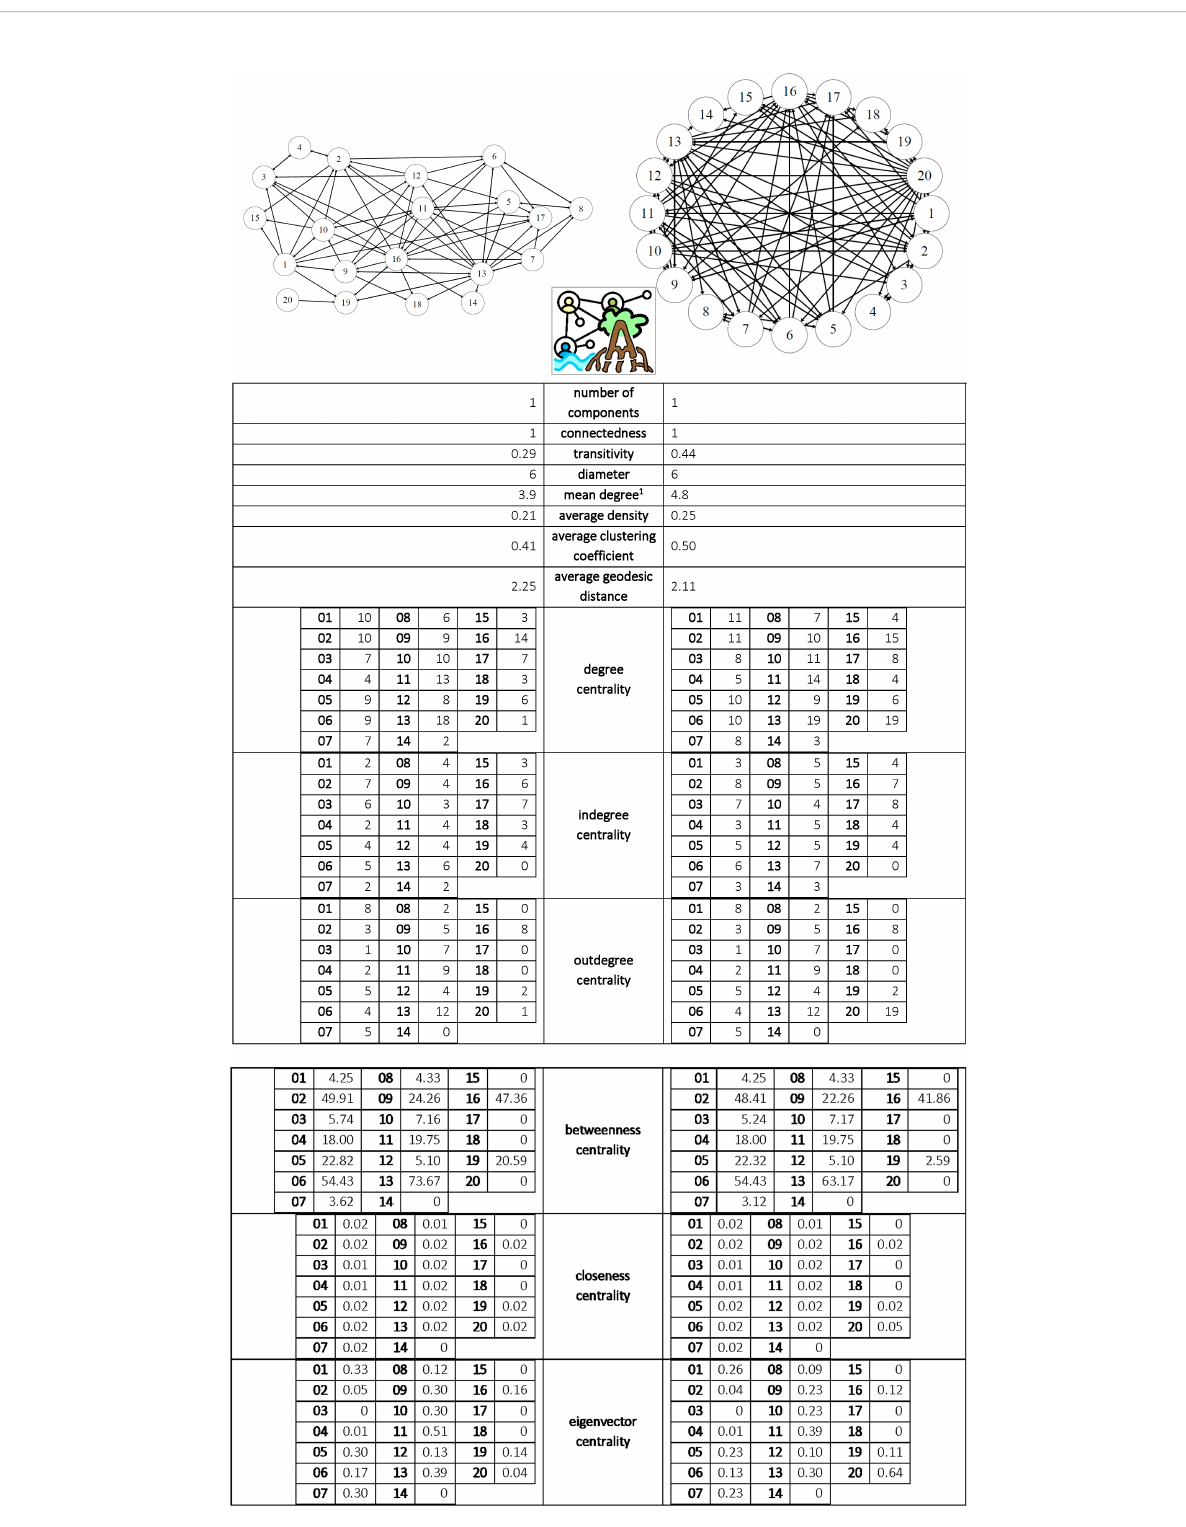
FIGURE 3 Theoretical social networks with directed ties based on the potential interactions described in Section 4.1, and with indices described in the Analysis task of Section 3.2.3. ( Left panel and column ) Network with web layout with 20_MEDIA interacting with 19_SCIENTIST alone. ( Right panel and column ) Network with circular layout with 20_MEDIA interviewing each and every other stakeholder. The centrality indices are for individual stakeholders and show each of them by number (following the same numbering as in Table 2). We refer to Appendix S7 for the relational data and sociomatrix corresponding to this social network and to Appendix S8 for de fi nitions of the SNA